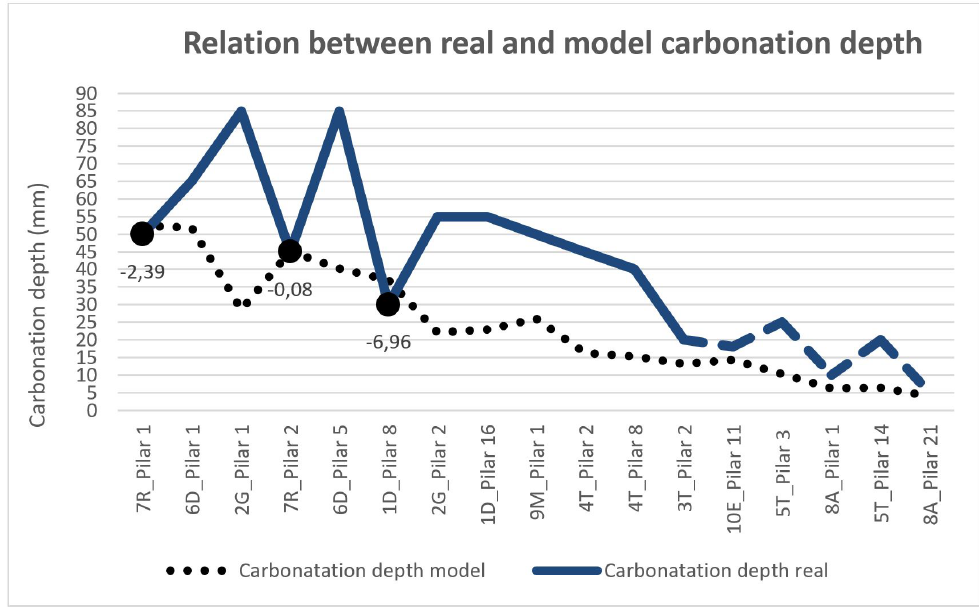
Figure 12. Real measurement (mm) and model depth carbonation